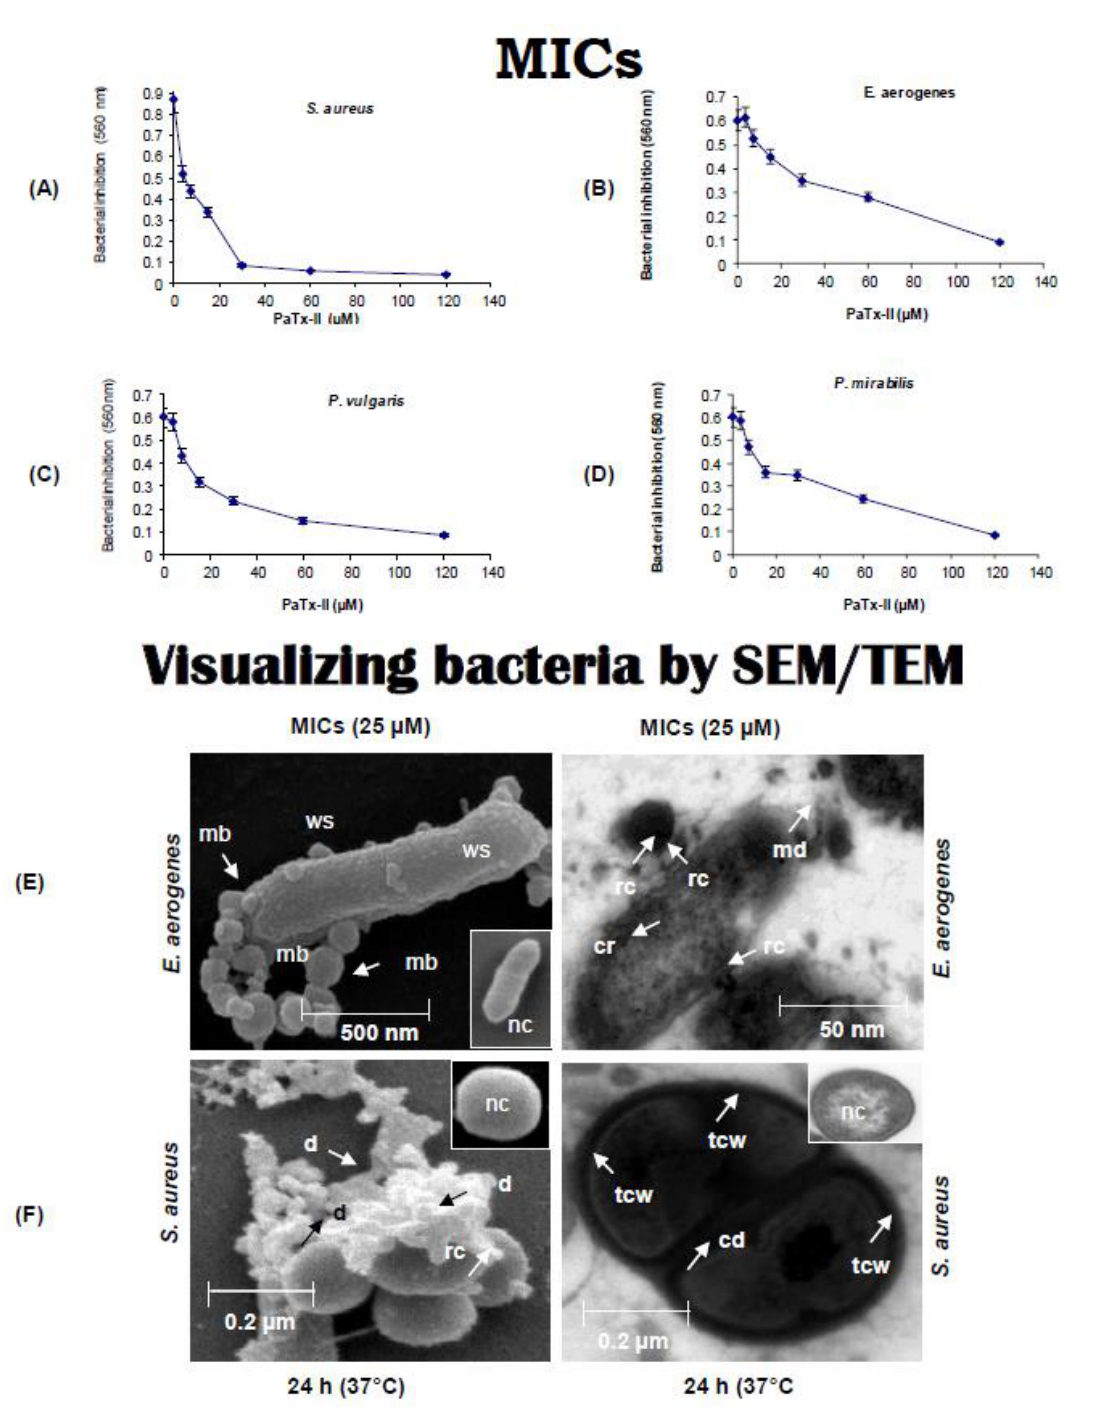
Figure 2. Antimicrobial potency of PaTx-II was tested against bacteria for 24 h at 37 °C. ( A – D ) Minimum inhibitory concentrations (MICs) were determined by standard procedures (see Methods). The inhibitory effect of PaTx-II was shown against S. aureus (MICs 25 µM), P. vulgaris (MICs 28 µM), P. mirabilis (MICs 35 µM) and E. aerogenes (MICs 25 µM); svPLA 2 shows the most potent inhibitory effect at the lowest dilutions. ( E , F ) Ultrastructural (scanning and transmission electron microscope) micrographs reveal that the PaTx-II-treated (MIC, 25 µM) bacteria show membrane blebs (mb), cell roughening (cr), debris (d), release of cellular contents (rc), wrinkled surfaces (ws), thickened cell walls (tcw), membrane damage (md) and cell death (cd) at the septal region after 24 h at 37 °C. Untreated normal cells (nc, insets) show none of these features.